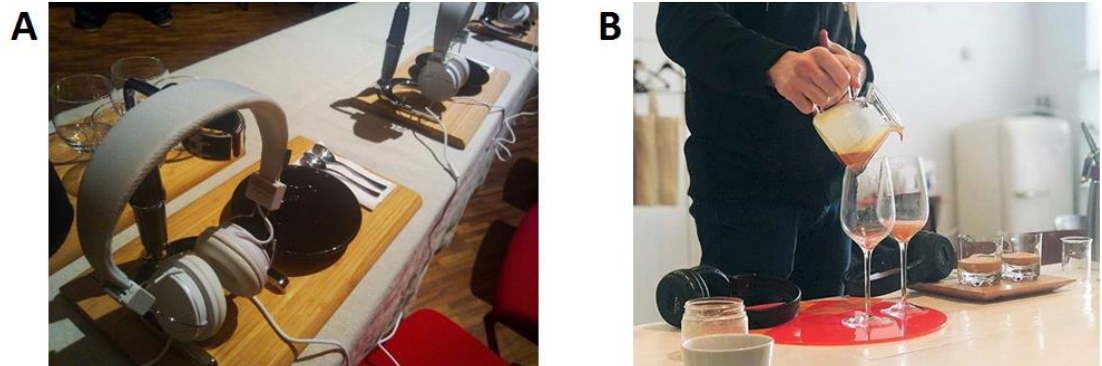
Figure 2. Multisensory experience designs during barista championships. ( A ) Rasmus Helgebostad’s sonically-enhanced coffee drink served as part of his entry in the 2011 Norwegian barista championships; ( B ) Matt Winton’s multisensory experience of the same signature coffee drink being served in two different setups (including distinct soundtracks) in the 2018 World Barista Championship [155].